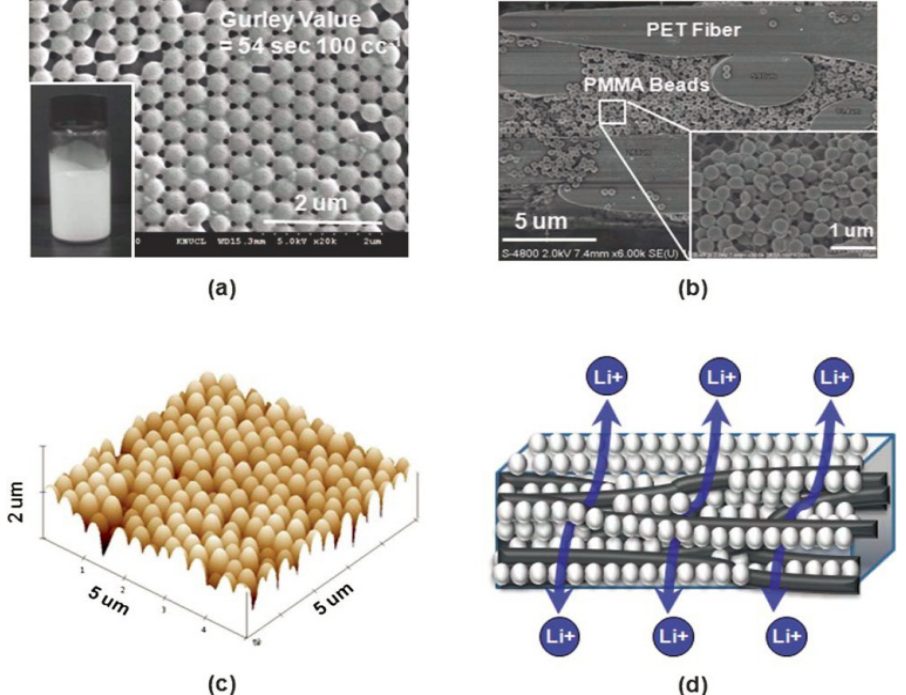
11. ( a ) Surface SEM of the composite nonwoven separator; the inset is a photograph of Poly(methyl methacrylate) (PMMA) nanoparticles suspension; ( b ) Cross-section SEM; ( c ) AFM photograph of the composite nonwoven separator; ( d ) Schematic illustration of nanoporous structure